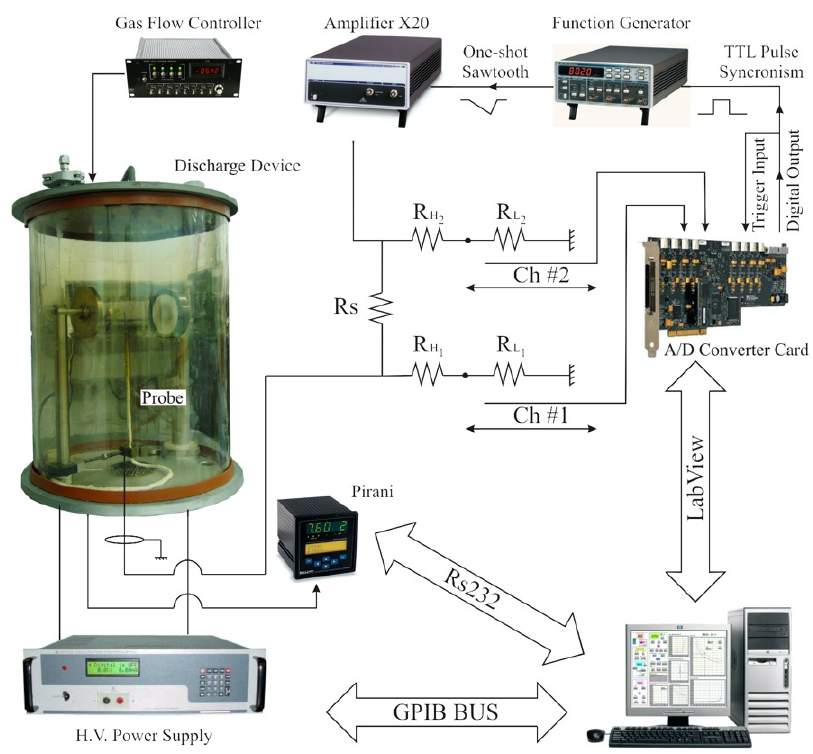
Figure 1. Experimental device and measurement setup. Reproduced with permission from Díaz Cabrera et al., Measurement; Reprinted with permission from ref. [14]. Copyright 2014 Elsevier.